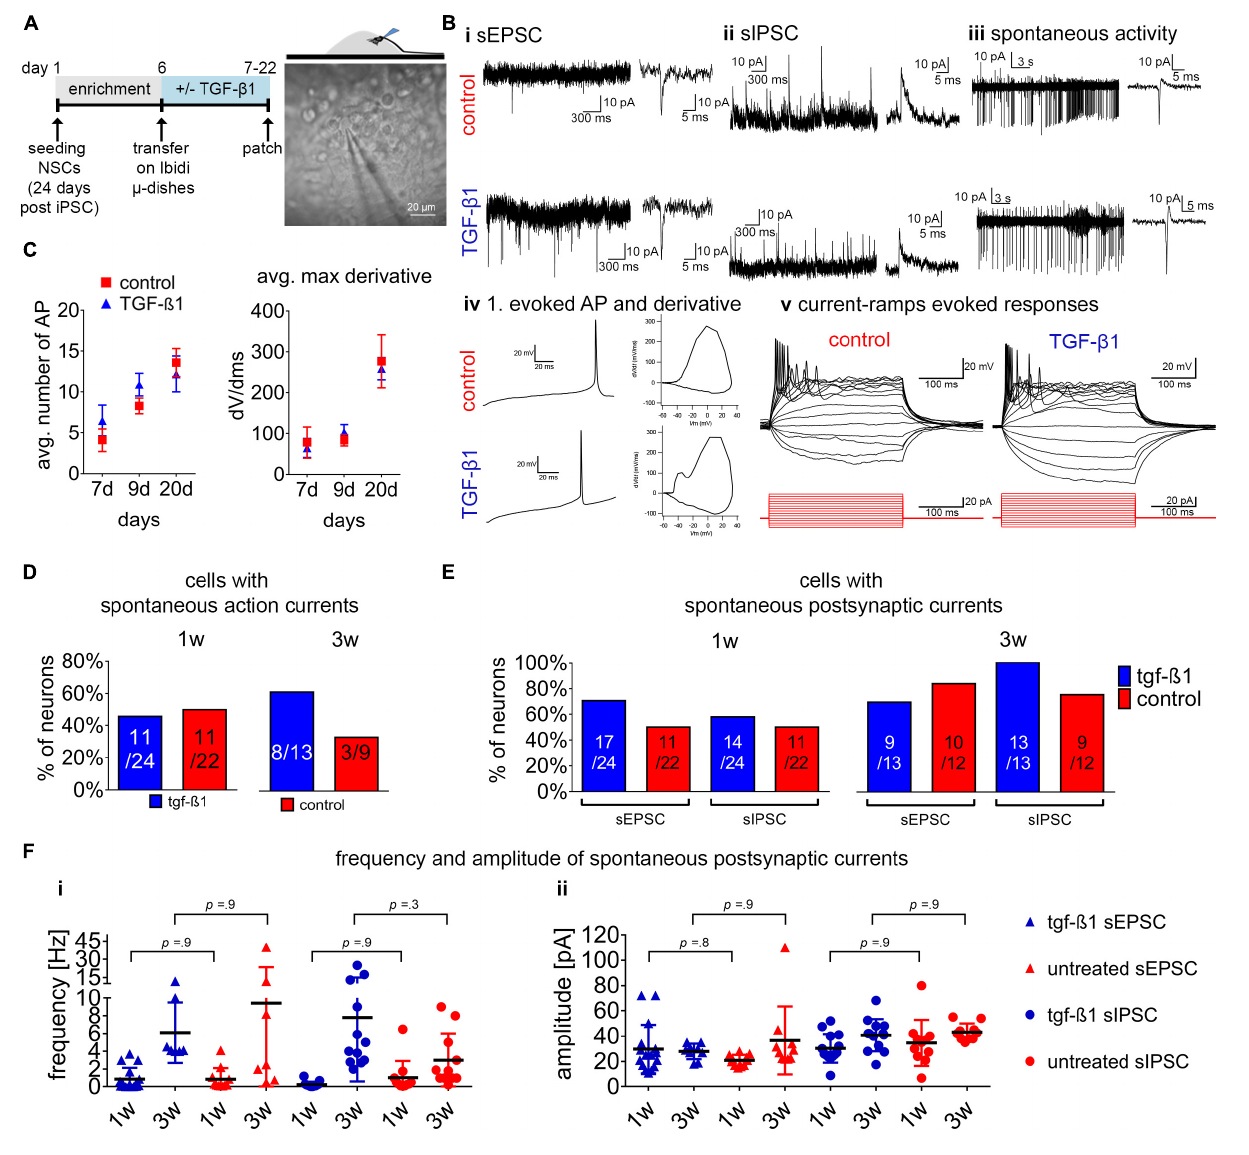
FIGURE 5 | Assessment of TGF- β 1 in functional neuronal maturation. (A) Schematic representation of the experimental design on the left and phase-contrast image on the right illustrating the position of the patch-clamp electrode at 3D-neural aggregates to assesses the electrophysiological functionality in untreated and TGF- β 1 treated hiPSC-NSC cultures. (B) Examples of recorded spontaneous synaptic (i) excitatory post-synaptic currents (EPSC), (ii) inhibitory post-synaptic currents (IPSCs), (iii) spontaneous action currents and (iv) first evoked action potential and phase-plan plots, and (v) example sweeps showing evoked action potentials in response to depolarizing current pulses in cells. Visualized injected current pulses (300 ms) starting from –20 toward 50 pA (15 pulses with steps of 5 pA, from hyperpolarizing to depolarizing) from the holding current. (C) Diagrams show the average number of action potentials and average max derivatives recorded at 1 and 3 weeks of cultivation. (D) Diagram presents the percentage of neurons showing spontaneous action currents after 1 and 3 weeks in culture. (E) Diagrams show the percentage of neurons showing spontaneous postsynaptic currents, and (F) frequency and amplitude of spontaneous postsynaptic currents recorded after 1 and 3 weeks in culture. Data are shown as mean ± standard deviation, one-way ANOVA with Tukey’s correction (multiple comparisons) was used to calculate the indicated p -values (line ChiPS4, N = 2, n = 2–3).